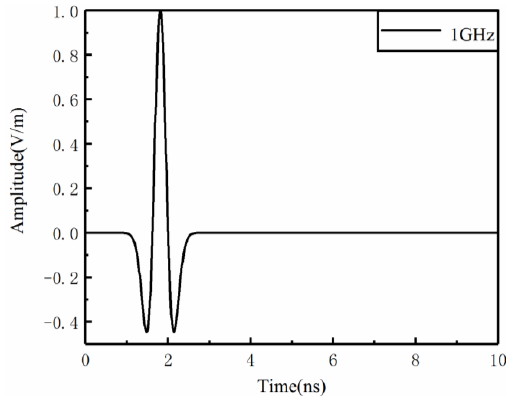
Figure 3. The waveform of the Ricker wavelet.